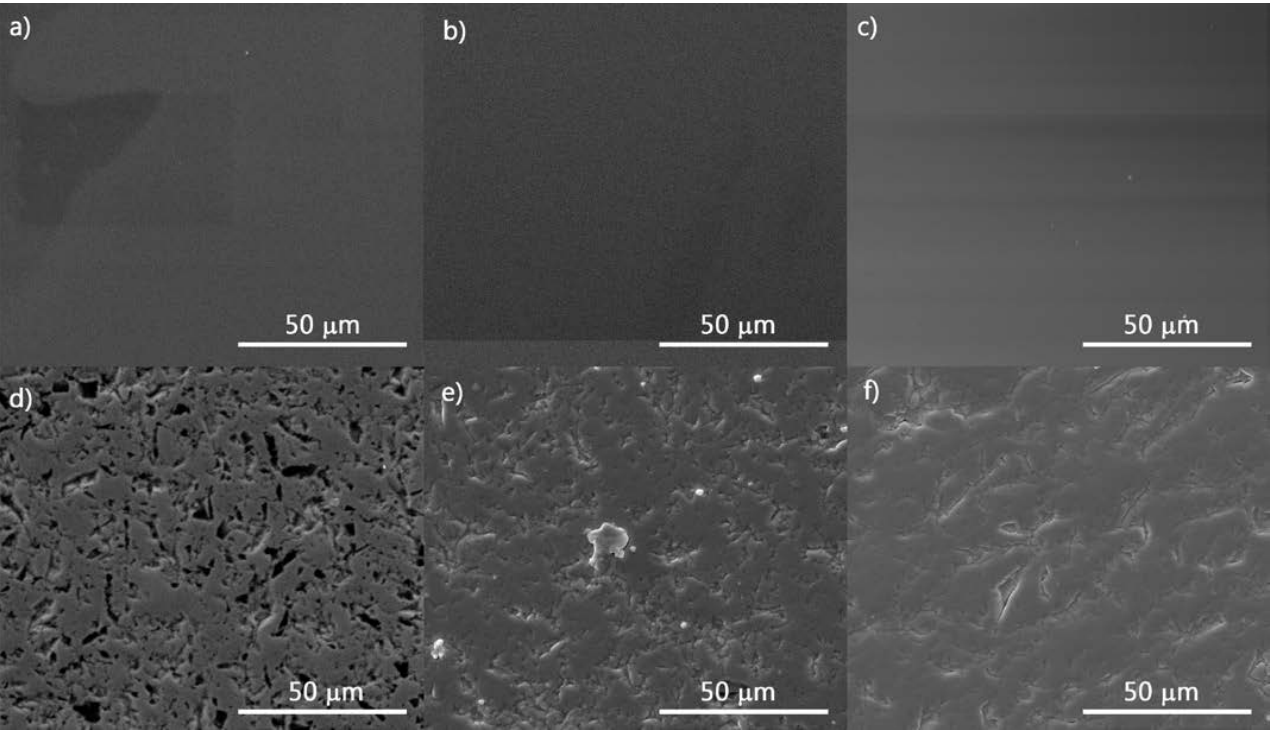
Figure 2. SEM images of the top surface morphology of D containing mixed Be-W layer deposited on W and Si substrates: ( a )W33 Si; ( b )W50 Si; ( c )W66 Si; ( d ) W33 W; ( e )W50 W; ( f ) W66 W. W and Si substrates: ( a ) W33 Si; ( b ) W50 Si; ( c ) W66 Si; ( d ) W33 W; ( e ) W50 W; ( f ) W66